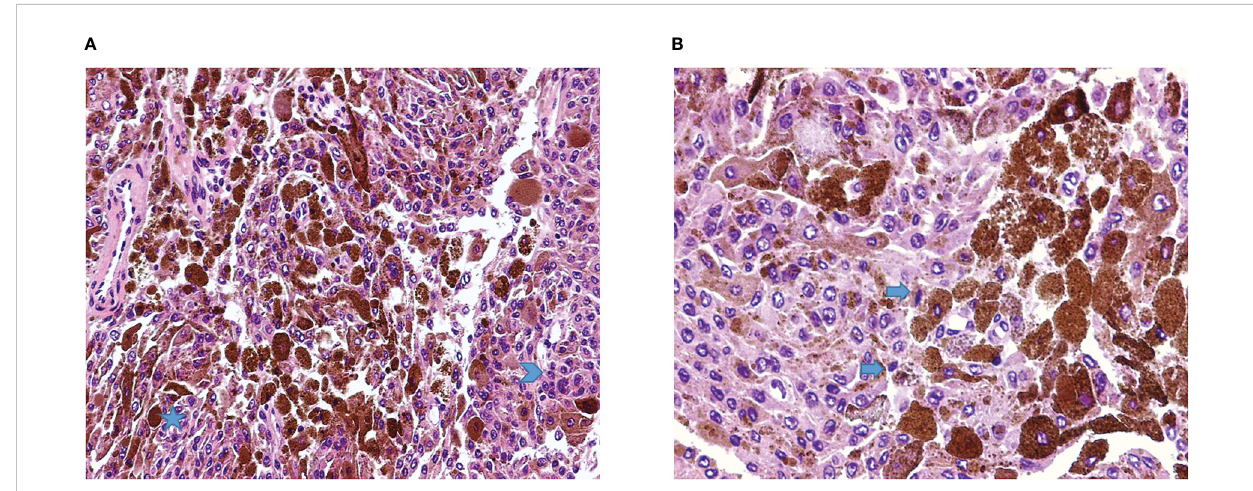
FIGURE 3 (A) Malignant melanotic nerve sheath tumor (MMNST) composed by pleomorphic cells, with spindle to polygonal shape, organized on fascicles (star) or sheets of roughly syncytial epithelioid cells (arrowhead), and numerous elements with heavy pigment deposits (H&E, magni fi cation 20x). (B) Cellular details show the presence of occasional mitoses (arrows) and brown fi nely granular melanin pigment (H&E, magni fi cation